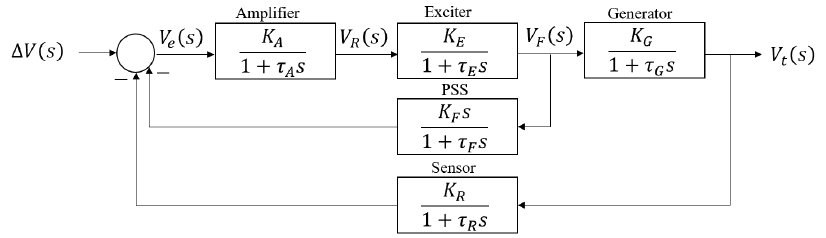
Figure 3. AVR block diagram.